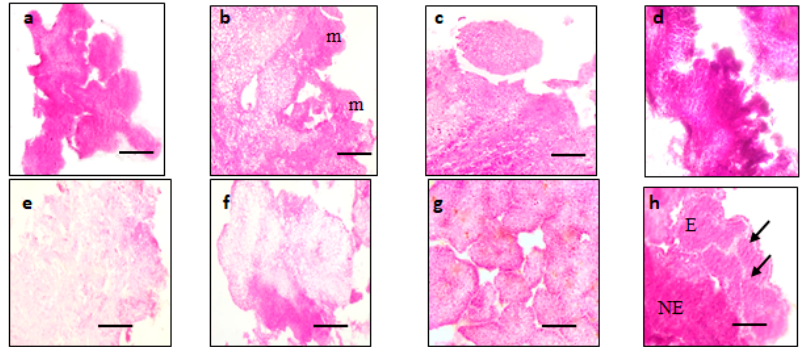
Figure 8. The histology analysis of MR220 ( a – e ) and MR220-CL2 ( f – h ), ( a ): embryogenic callus; ( b ): densely meristematic cells (indicated as m); ( c ): Pro-embryo with globular shape; ( d ): Cluster of small, globular embryogenic callus unit at the peripheral region; ( e ): the non-embryogenic callus with loose cell and large space; ( f ): Embryogenic callus (E) and non-embryogenic (NE); ( g ): The globular embryogenic callus unit covered with epidermis-like tissue; ( h ): Embryogenic callus units at the peripheral region of the cell under epidermis-like tissue (indicated as arrows) (Bars = 100 mm for ( a – h )).